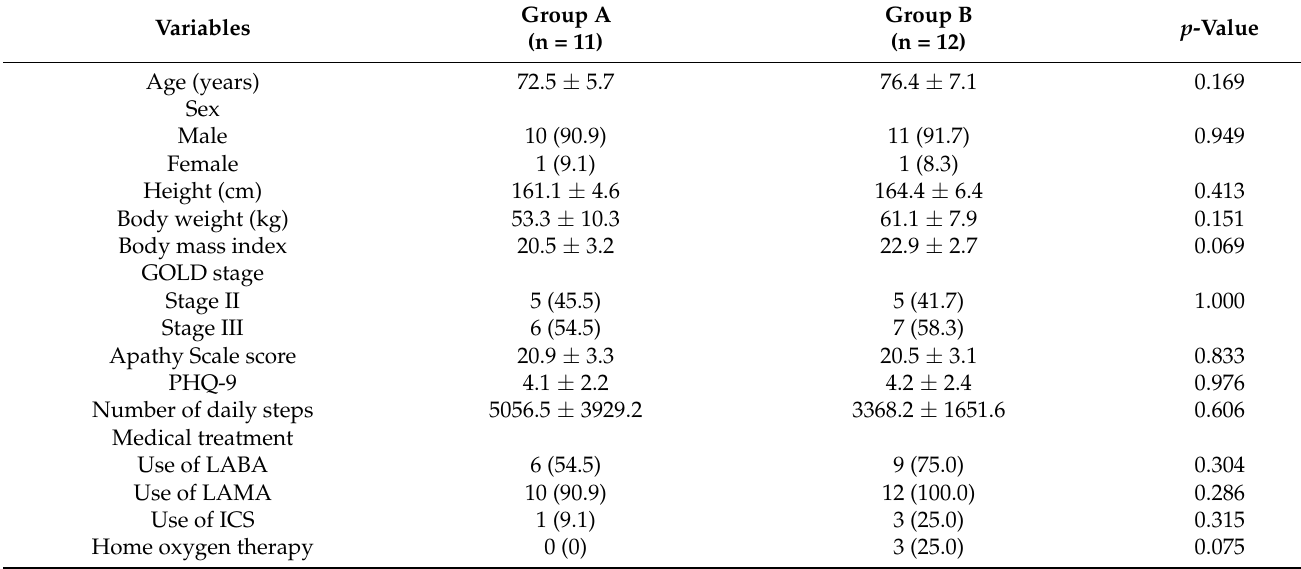
Table 1. Baseline characteristics of patients with chronic obstructive pulmonary disease.